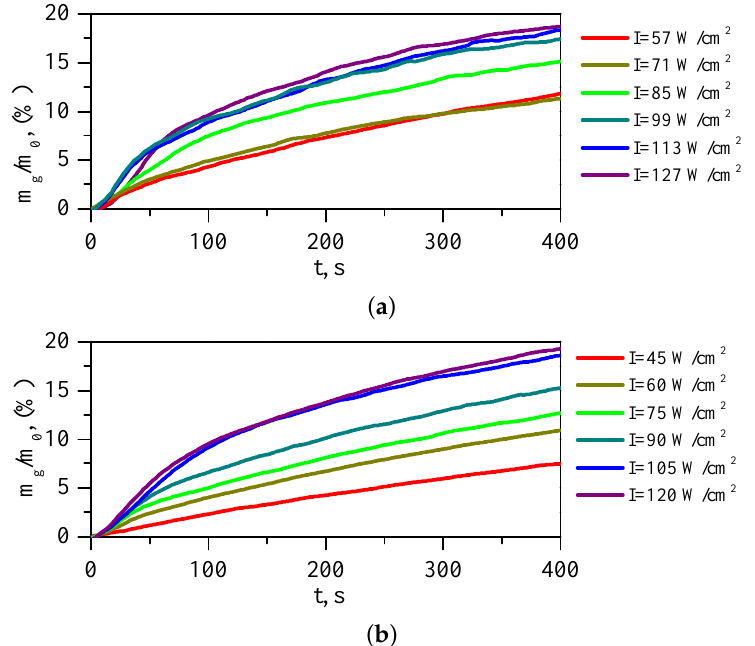
Figure 5. Weight of syngas vs. conversion time of gasification of peat ( a ) and lignite ( b ) at different light flow